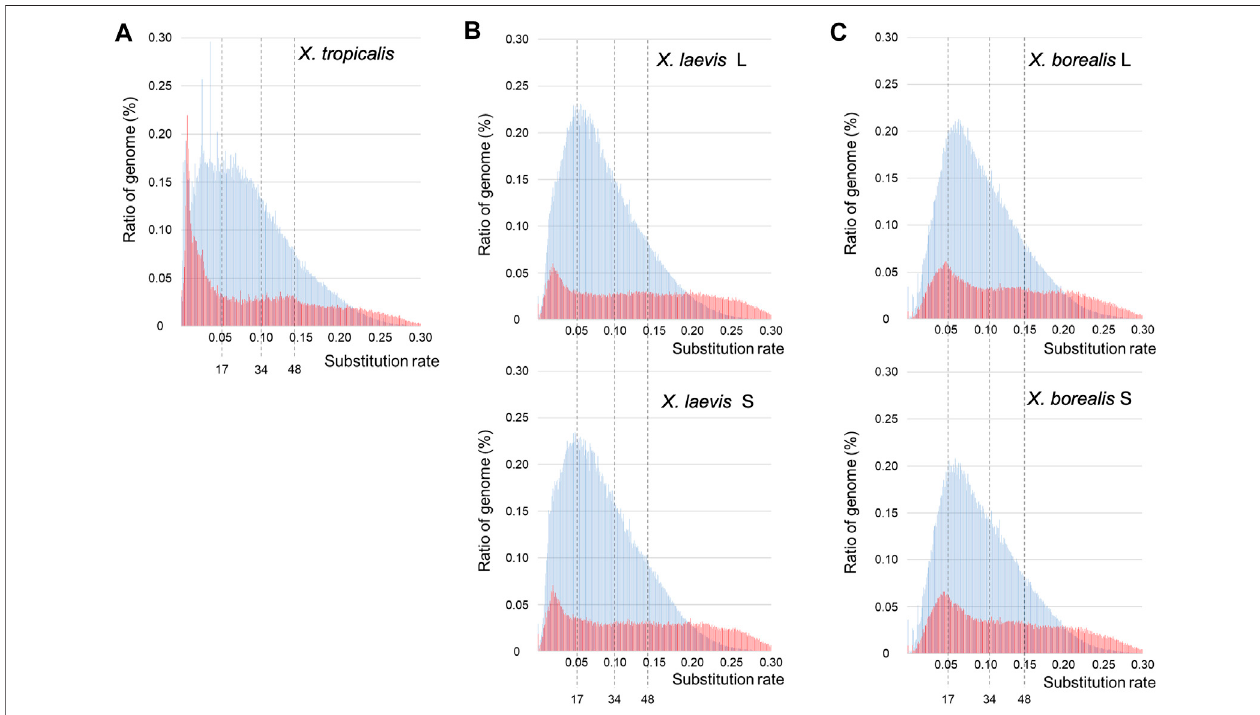
FIGURE 3 | Landscapes of DNA transposons and retrotransposons in the three Xenopus species. The substitution ratios of DNA transposons (blue) and retrotransposons (red) in X. tropicalis (A) , X. laevis L and S (B) , and X. borealis L and S (C) are shown on the horizontal axis. Proportion (%) of the transposons to each genomeDNAareshownontheverticalaxis.Thenumbers34and17indicatespeciationandhybridizationtime(mya)ofthepredictedLandSspecies,whichcorrespond to the substitution ratios, 0.10 and 0.05, respectively.